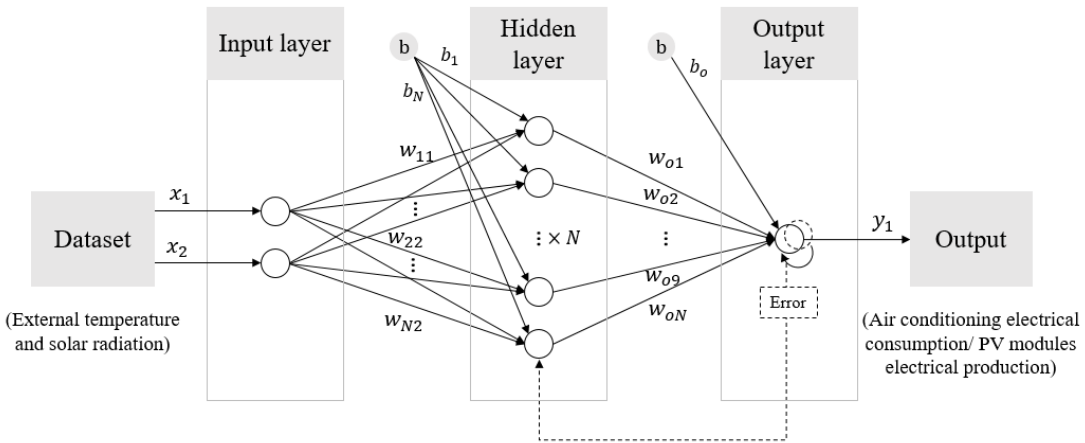
Figure 3. Artificial Neural Network (ANN) model architecture.